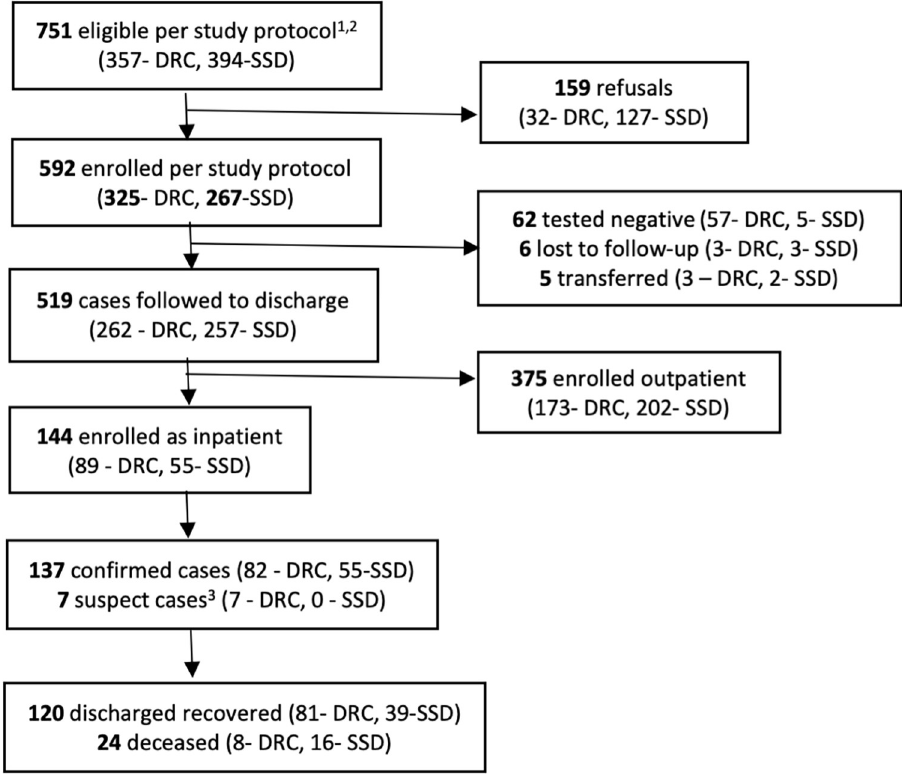
Fig 1. Study participant flow